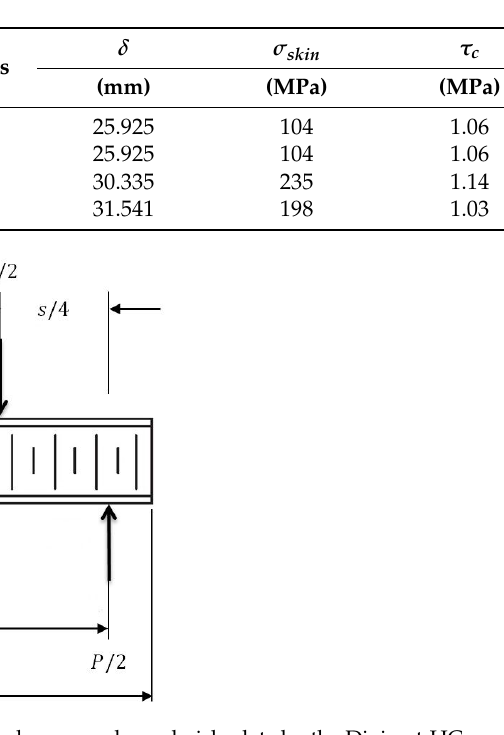
Table 9. Dimensions of honeycomb sandwich models of helicopter floor.